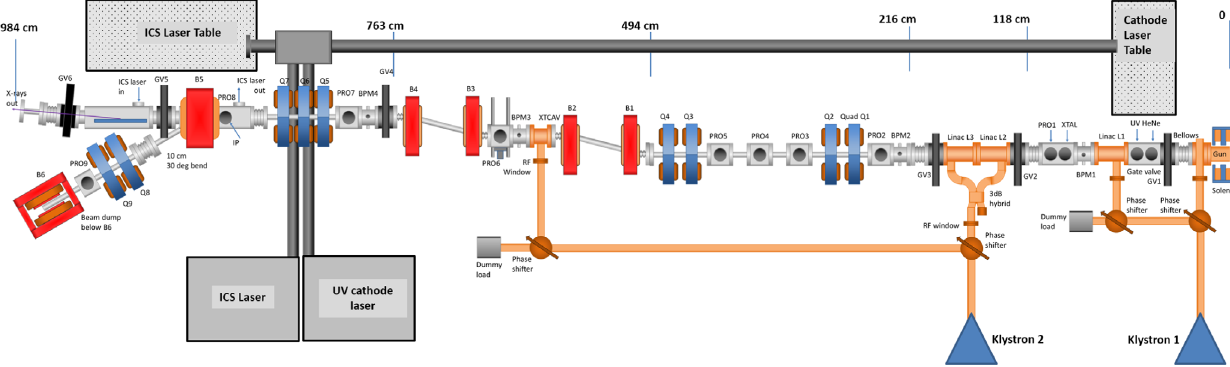
FIG. 1. Schematic of the compact coherent x-ray source with rf photo-injector, electron diffraction crystal, X-band linac, EEX line and ICS laser interaction area. Entire assembly is approximately 10 m